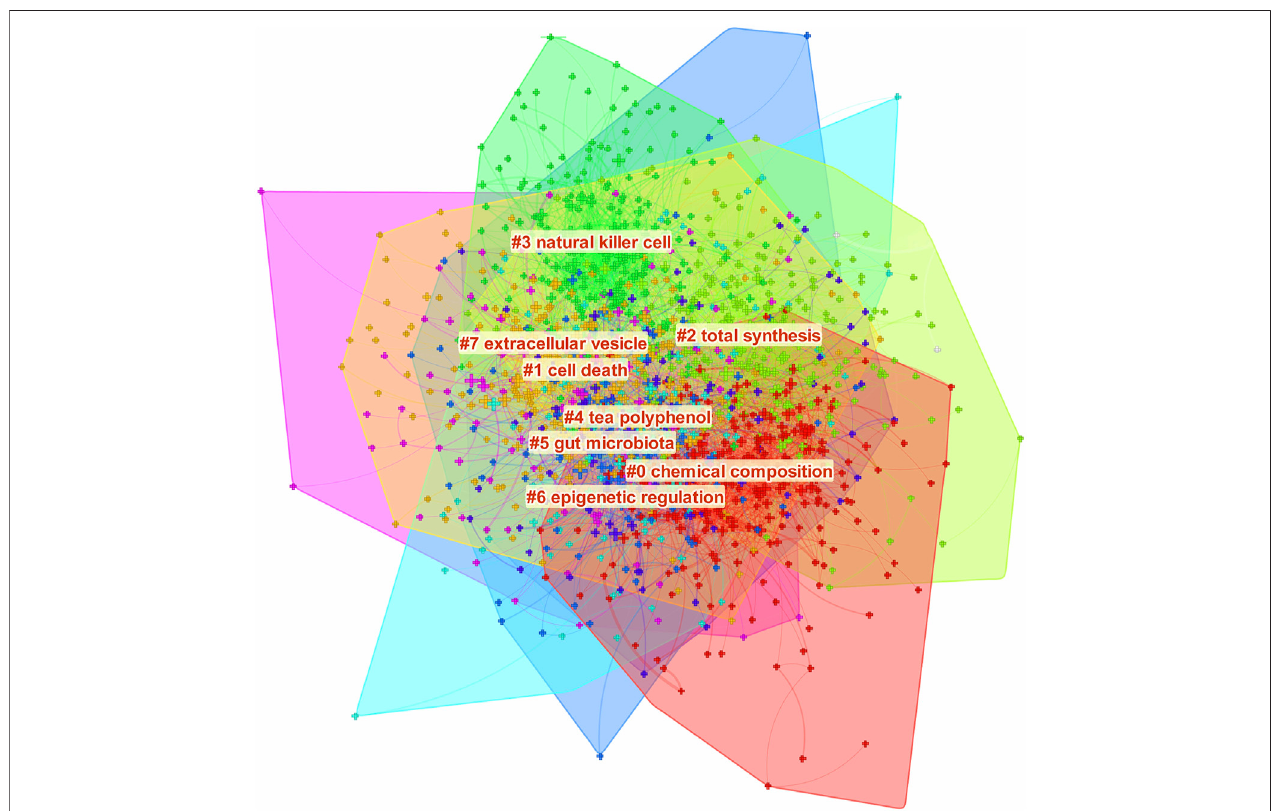
FIGURE 5 | The cluster of keywords related to natural products in cancer research. The different colors mean different clusters.